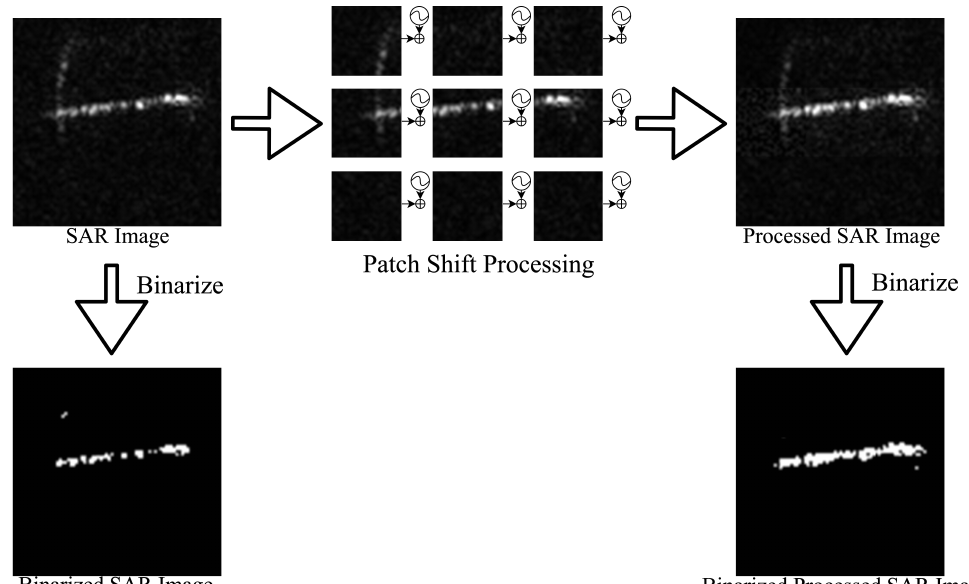
Figure 5. The illustration of patch shift